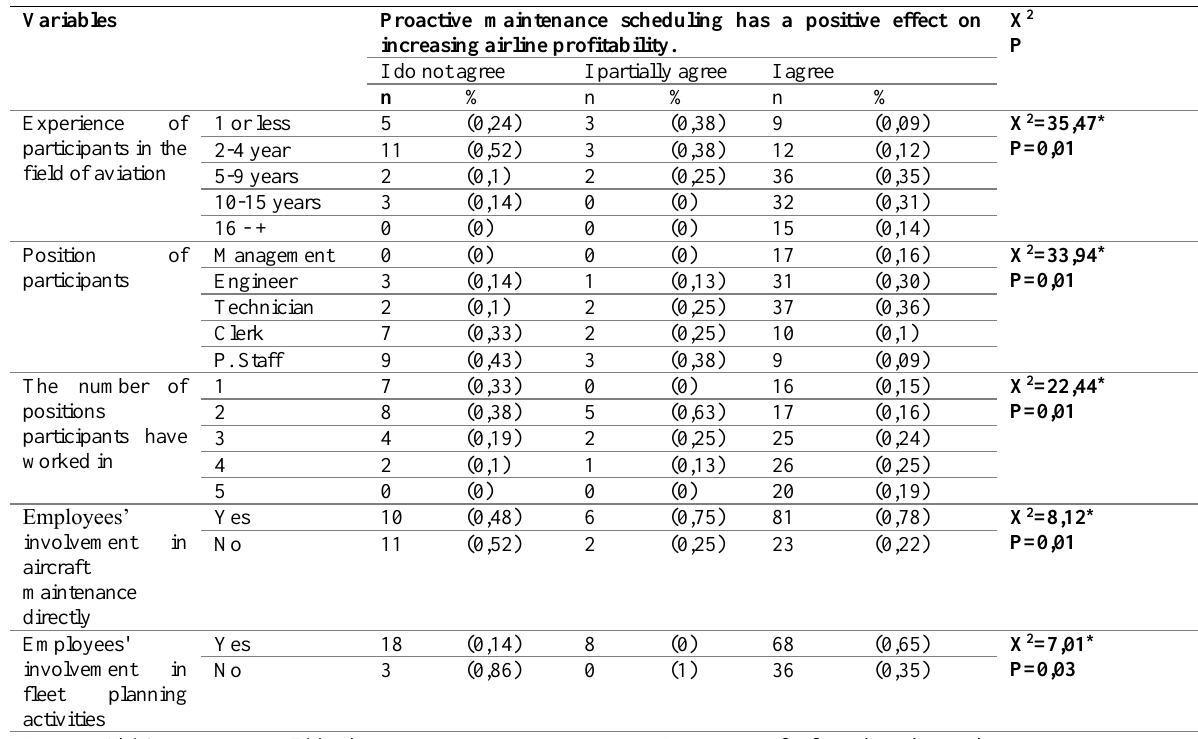
Table 8: Comparison of Participants' Answers on the Statement of "Proactive Aircraft Maintenance Planning Has a Positive Effect on Increasing Airline Profitability" with Experience-Related Variables Variables Proactive maintenance scheduling has a positive effect on increasing airline